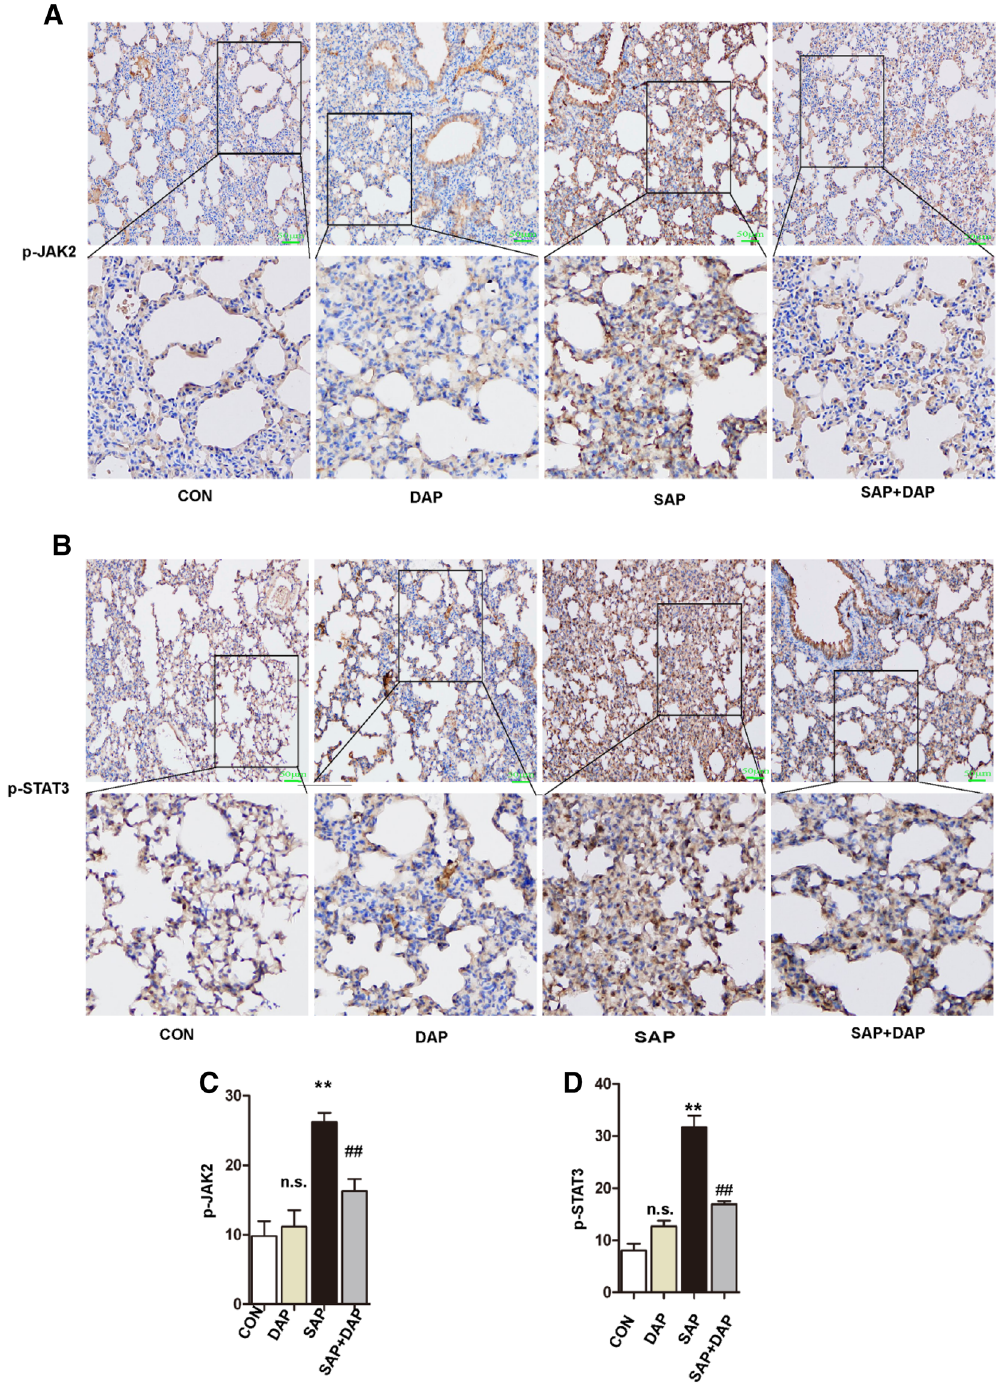
Figure 6. Daphnetin inhibits activation of the JAK2–STAT3 pathway in the lungs of mice with PALI. Immunohistochemical staining of p-JAK2 ( A ) and p-STAT3 ( B ) in lung of each group. The magnification of each histological images were × 200. Quantitative analysis of p-JAK2 ( C ) and p-STAT3 ( D ). The data are presented as the means ± SD. The histograms were created using GraphPad 5 software (GraphPad Prism 5.01 http:// www. xdowns. com/ soft/ xdown s2009. asp? softid= 49668 & downid= 60& id= 52443). The quantitative analysis of immunostaining was used by ImageJ software(Image J 2 system software https:// imagej. net/ Downl oads). CON group, l-arginine vehicle + daphnetin vehicle; SAP group, l-arginine + daphnetin vehicle; DAP group, l-arginine vehicle + daphnetin; SAP + DAP group, l-arginine + daphnetin. ** P < 0.01 versus CON group; ## P < 0.01 versus SAP group, n.s. P > 0.05 versus CON group. Scale bars: 50